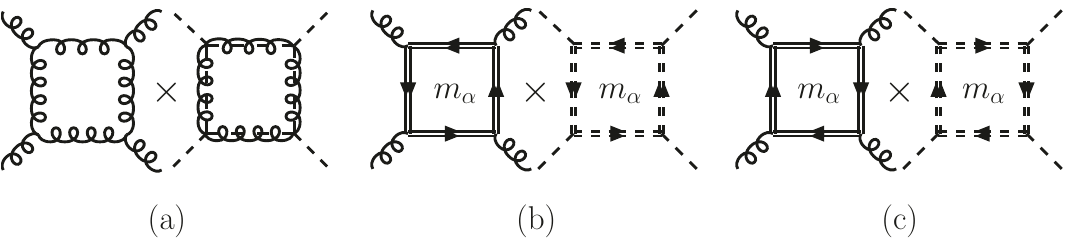
Figure 7 . The three types of box diagrams in the one-loop four-vector spontaneously-broken YMESG amplitude. The contributions are, (a) the graviton and massless vector, (b) the massive W (cid:11) vectors, and (c) the massive W (cid:11) vectors. These are given by double copies between spontaneously- broken SYM (left factors) and explicitly broken YM + (cid:30) 3 theory (right factors). The remaining triangle and bubble contributions are obtained from the boxes through the Jacobi and commutation relations of color/kinematics duality. See (cid:12)gure 6 for